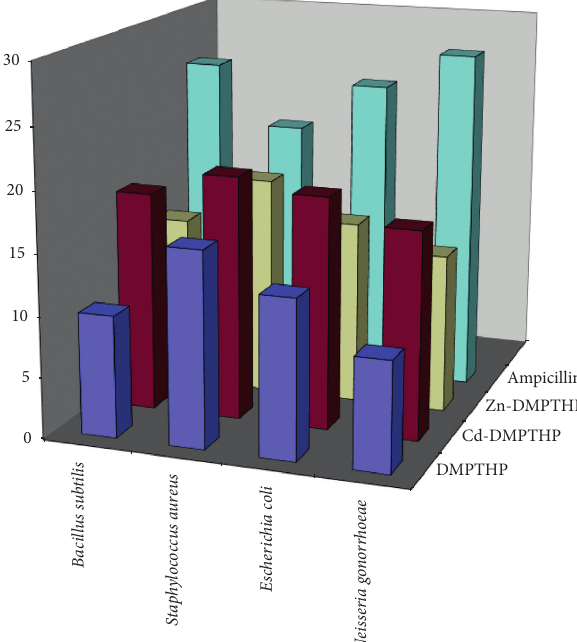
Figure 3: Antibacterial activity of the synthesized compounds.